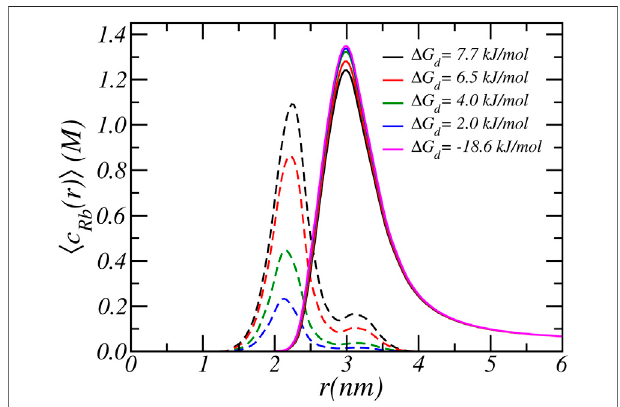
FIGURE7| TheaveragedegreeofchargeasfunctionofreservoirpH for fi xed dielectric constant, varying dielectric constant and varying dielectric constantpluselectrostaticself-energy.ThereservoirhasaRbClconcentration of [RbCl] = 50